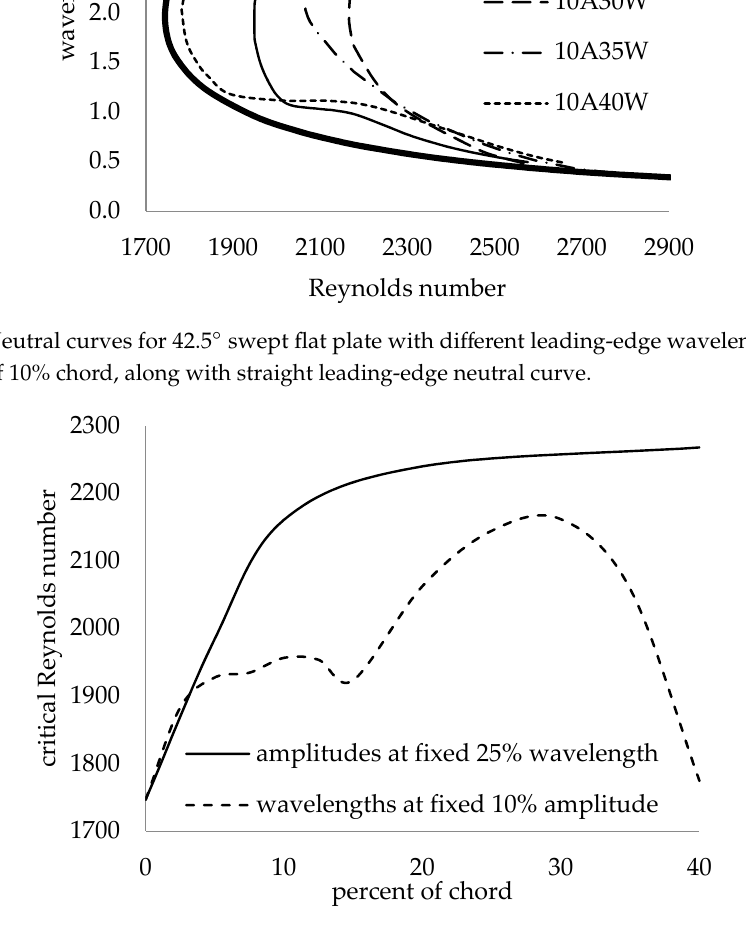
Figure 19. Amplification curves at fixed 2300 Reynolds number. 3.4.2. Global Analysis A global stability analysis was performed for different LE geometries by calculating the critical Reynolds numbers and maximum amplification factors at span locations between successive LE peaks. The effect of the LE wavelength is presented first. Figure 20 shows the critical Reynolds numbers for wavy LE geometries at a fixed 10% amplitude and 30%, 15%, and 7.5% wavelengths (10A30W, 10A15W, and 10A075W, respectively). The critical Reynolds numbers are plotted against a nondimensionalized LE wavelength, with integer values of the nondimensionalized wavelength corresponding to the LE wave peak, and values of 0.5 and 1.5 corresponding to the wave trough. The 10A30W geometry exhibits strong oscillations across the span, with a peak critical Reynolds number near 1.0 (the dotted vertical line shows where the local analysis was carried out, Figure 17) and 2.0 and a low critical Reynolds number at or slightly below the straight leading-edge case near 0.25 and 1.25. The effect of sweep is characterized by the steep decline in the critical Reynolds number past the peak near the wavelength of 1.0 and a slow gradual rise past the wavelength of 1.25. By contrast, for the 10A15W and 10A075W geometries, the critical Reynolds number had less pronounced